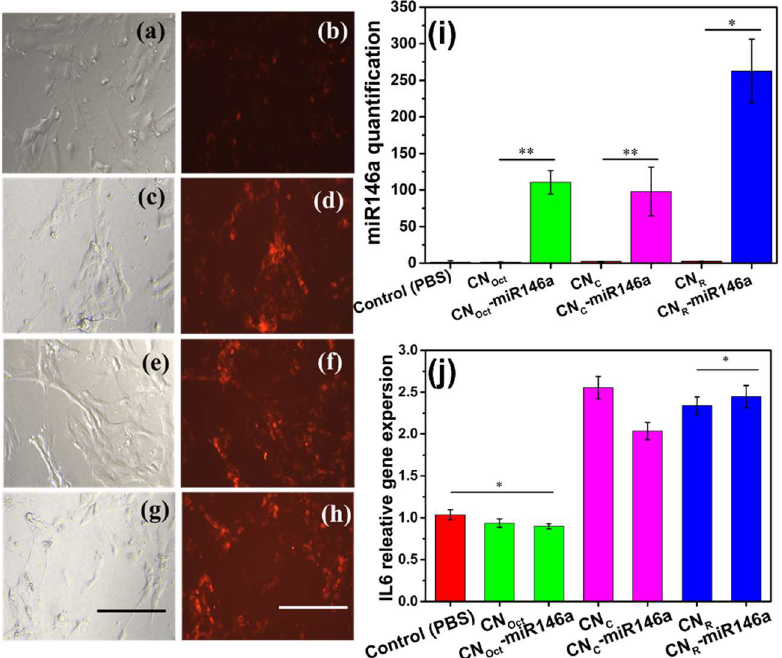
Figure 6. The bright field/fluorescence images, miR146a quantification and, IL6 relative gene expression were analyzed on miR146a conjugated in different shapes of CNPs. Control cells and 0.4 ng/ µ L of fluoroprobe tagged miR146a conjugated octahedra, rod, and cube CNPs treated cells bright filed and fluorescence image were shown in the image ( a – h ). The scale bar is 100 µ m. ( i , j ) miR-146 and IL-6 gene expression following treatment of MDF with pure and miR-146a conjugated different shapes of CNPs. miR-146a levels were significantly higher in miR146a different shape CNPs than in control (PBS) treated sample ( i ). Octahedra CNPs and miR146a-octahedra CNP treated cells considerably reduced IL-6 gene expression compared to control ( j ). Bars indicate statistical significance with p < 0.0001 ** and p < 0.05